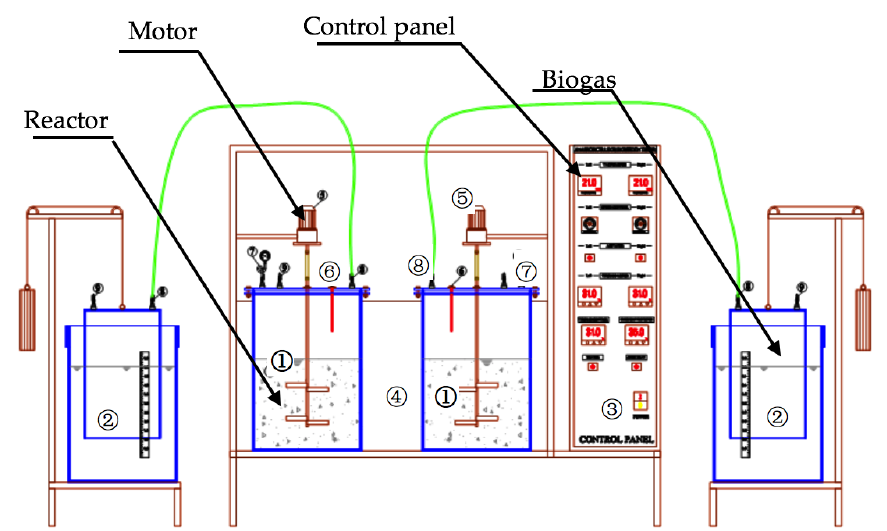
Figure 3. Flow chart of anaerobic digestion pilot—AF-10-2. Note: ① reactor, ② biogas container; ③ control panel, ④ water bath; ⑤ motors, ⑥ temperature sensor, ⑦ pressure meter, and ⑧ gas vales.